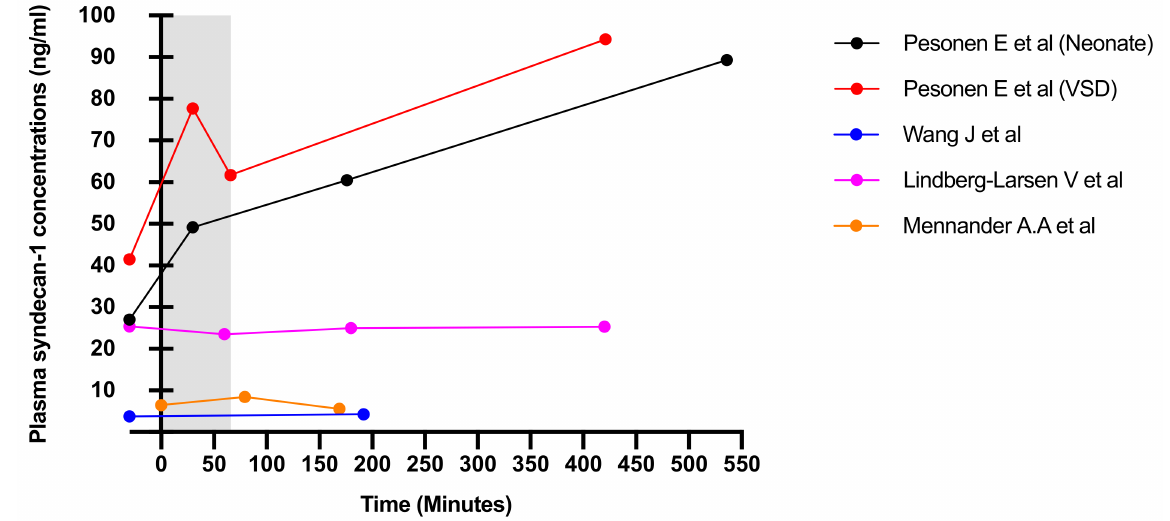
Figure 3. Changes in plasma syndecan-1 concentration in the control groups of the included articles. Values lower than x = 0 represent blood samples taken pre-operative. Values within the grey region are samples recorded